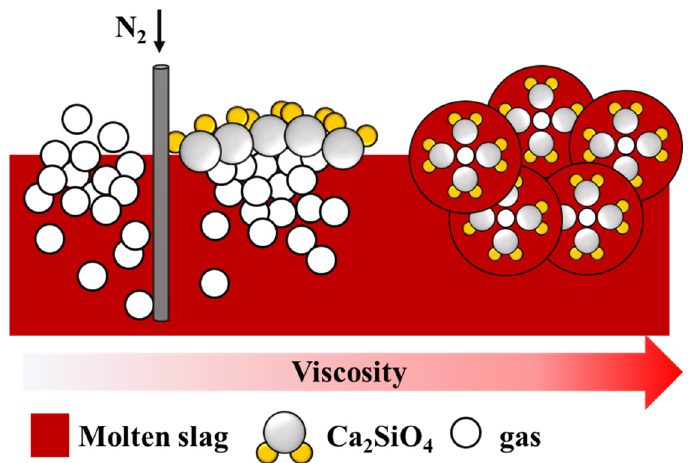
Figure 11. Foaming mechanism between gas and particles.